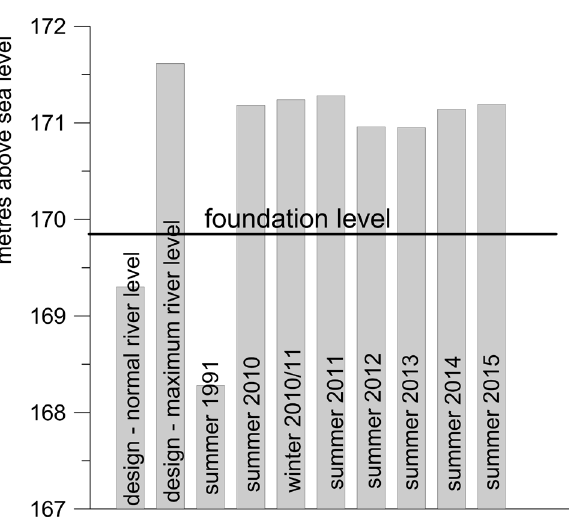
Figure 5: The levels of underground water in relation to foundation level: the water in the river in accordance to design drawings (normal and maximum) and the water level found nowadays (maximum).